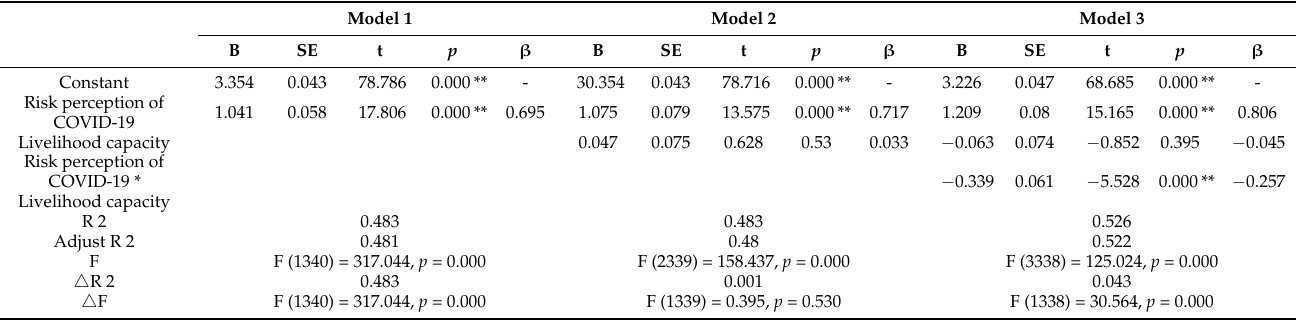
Table 7. Moderation effect test